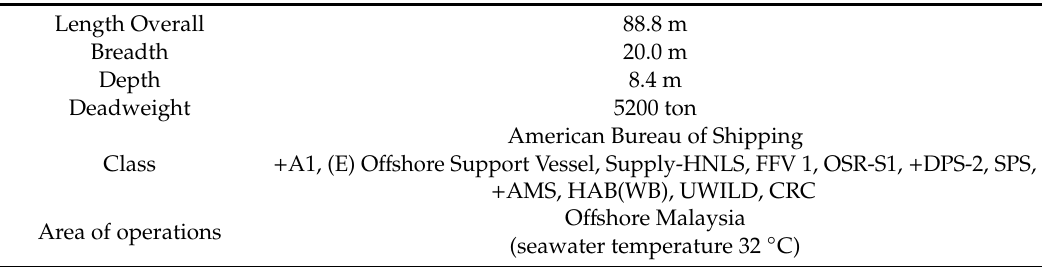
Table 2. General specifications of case ship.